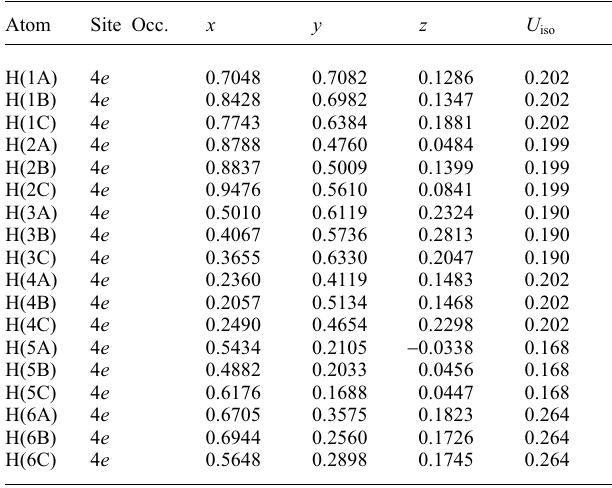
Table 2. Atomic coordinates and displacement parameters (in Å 2 )